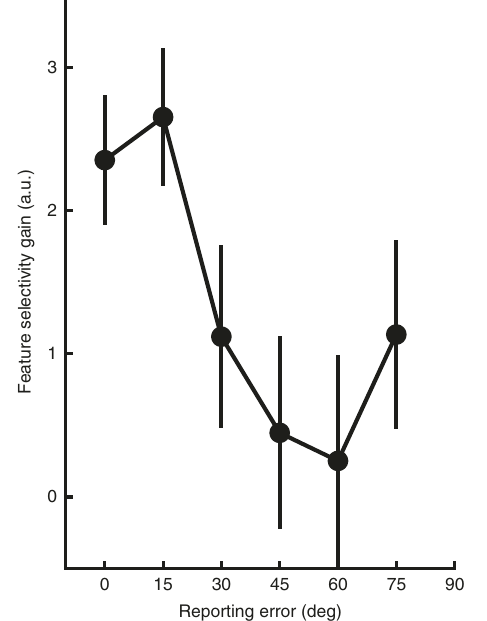
Fig. 7 Gain of feature-selective information for T2 items presented at Lag 3 in Experiment 2, plotted as a function of reporting error. Forward encoding results were averaged across early timepoints (100 – 150 ms), and were binned by the absolute difference between the presented and reported orientations (in 15° increments). Each bin is displayed as the starting value (e.g., 0° incorporates errors from 0° to 15°). Gaussians were fi tted to quantify selectivity with the gain parameter shown here. Feature selectivity was highest when participants reported the orientation to within 30° of the presented orientation, and declined signi fi cantly with larger reporting errors. Error bars indicate ∓ 1 standard error of the mean.